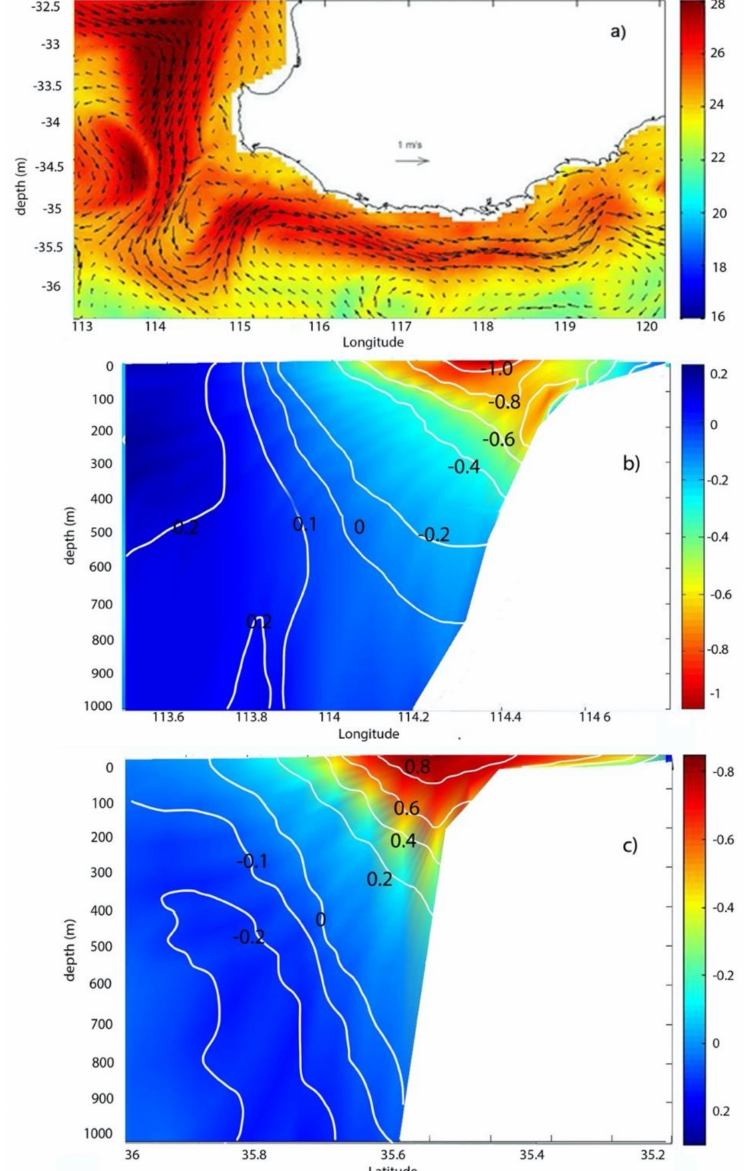
Figure 5. Model output with wind stress forcing representing autumn conditions. ( a ) Sea surface temperature ( ◦ C) and current velocities; ( b ) the cross-section across transect R (Capes region) showing the north-south velocity (m / s); ( c ) the cross-section across transect K (Albany) showing the east-west velocity (ms − 1